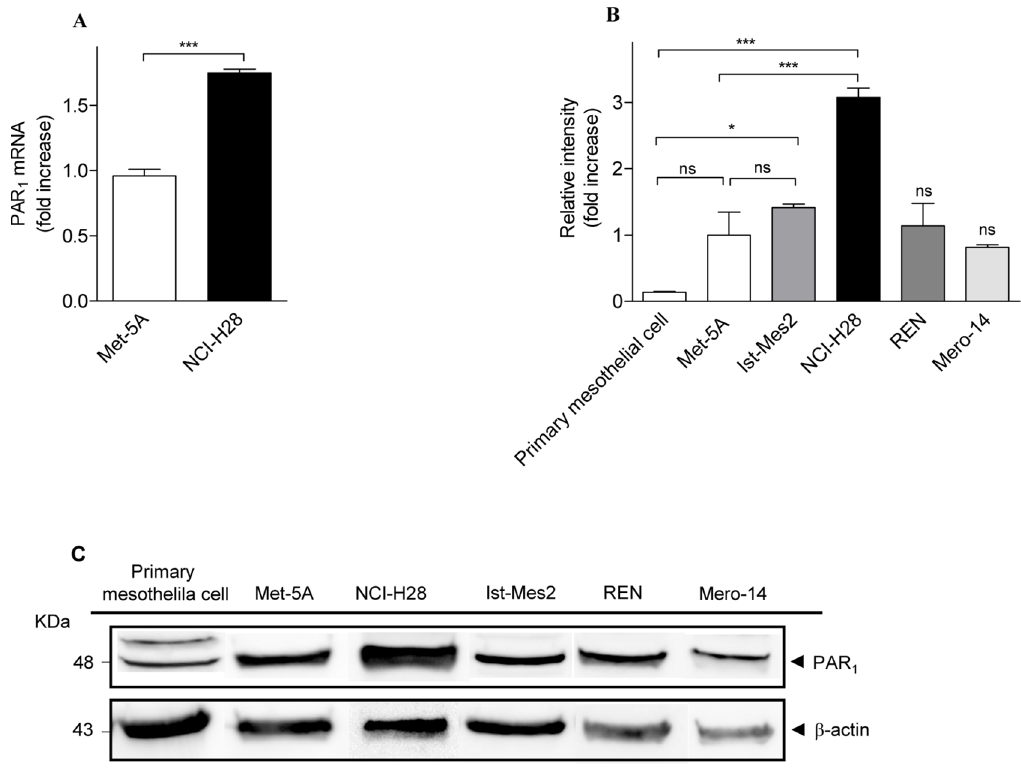
Figure 1. NCI-H28 cells over-express PAR 1 . A, relative expression levels of PAR 1 mRNA in Met-5A and NCI-H28 cells as determined by real time RT-PCR. B, relative expression levels of PAR 1 protein in primary mesothelial cells, Met-5A, NCI-H28, REN, Ist-Mes2, and Mero-14 cell lines as determined by immunoblot analysis followed by densitometric quantitation. Data are expressed as arbitrary unit (fold increase over Ctrl, Met-5A cells) after normalization by b -actin. Data shown are mean 6 SEM of three independent experiments. The differences in PAR 1 expression levels between Ctrl (Met-5A or primary mesothelial cells) and MPM cells were significant (*P # 0.05, ***P # 0.001) by one-way ANOVA followed by Bonferroni’s multiple comparison test (n=3). C, a representative